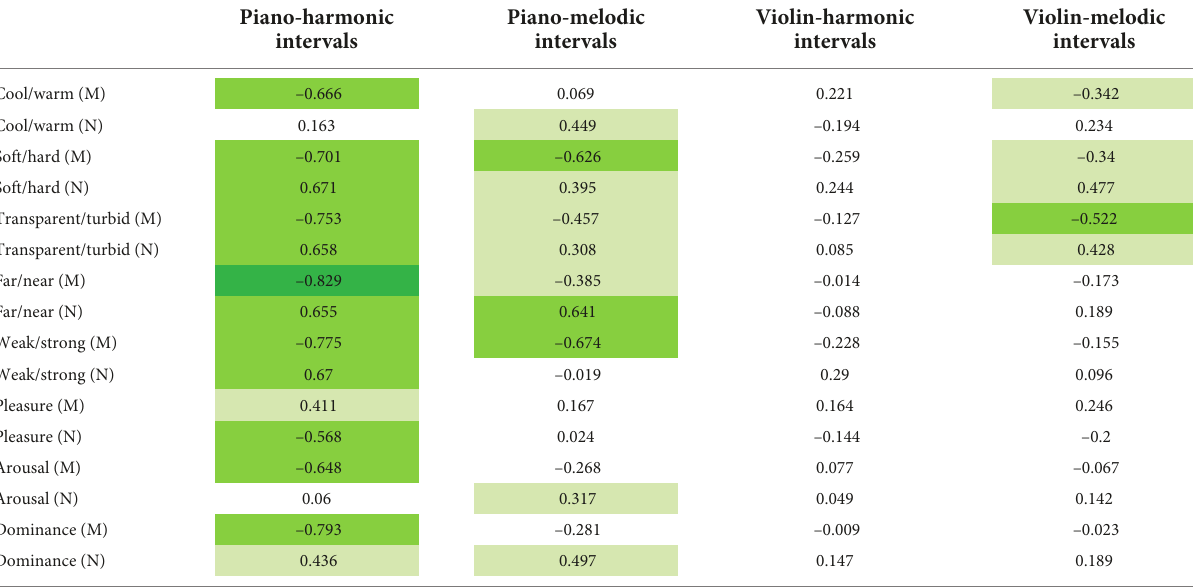
TABLE 5 The Pearson’s correlation coefficient matrix between multi-color perceptual attributes and the interval consonance attribute. Piano-harmonic